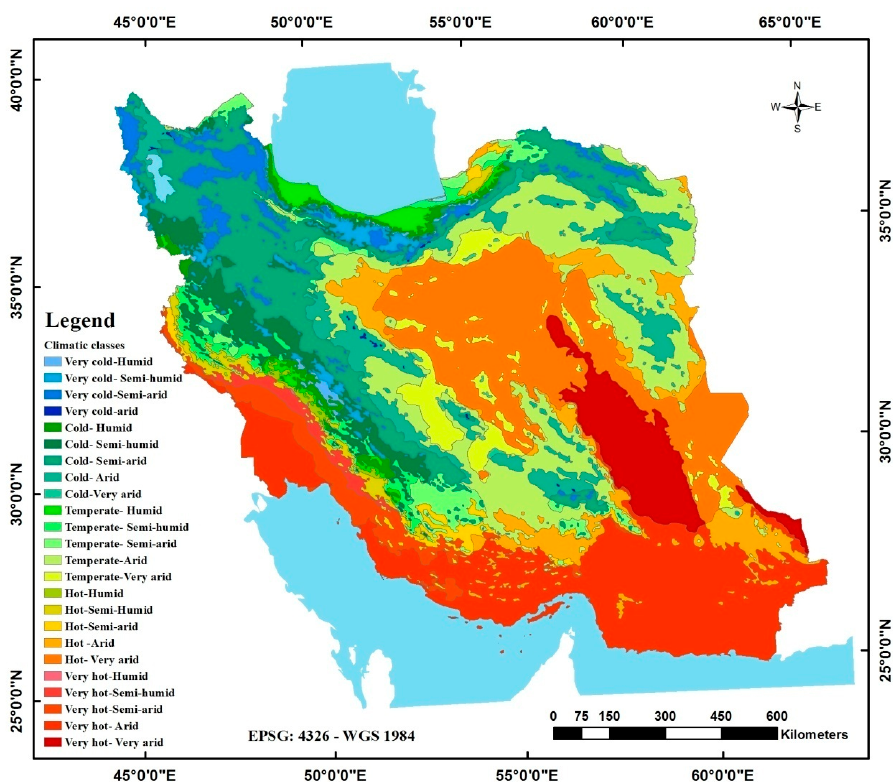
Figure 6. Spatial variability of the climatic classes.